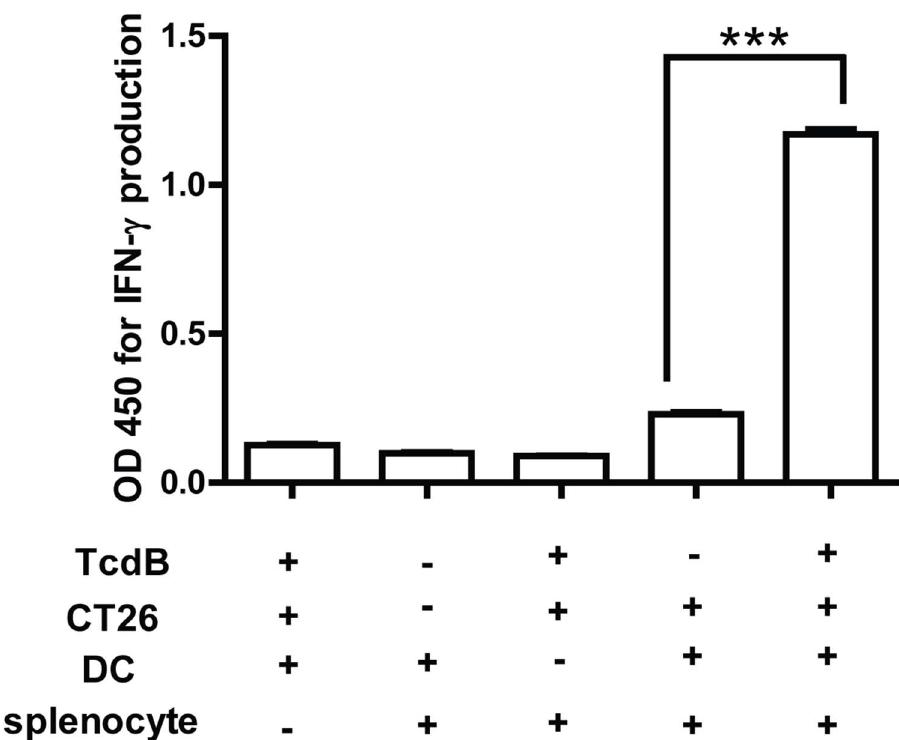
Figure 2. IFN- c production induced by BMDCs loaded with TcdB-treated tumor cells. Autologous splenocytes were co-cultured with bone marrow DCs (BMDCs) preloaded with live or TcdB-intoxicated CT26 cells for two weeks, and the supernatant was collected to measure IFN- c production by ELISA. Splenocytes incubated with mere DCs or mere TcdB-treated tumor cells were set as controls. The data represent the mean of three independent determinations 6 SEM. ***represents P , 0.001 (unpaired two-tailed t- test).